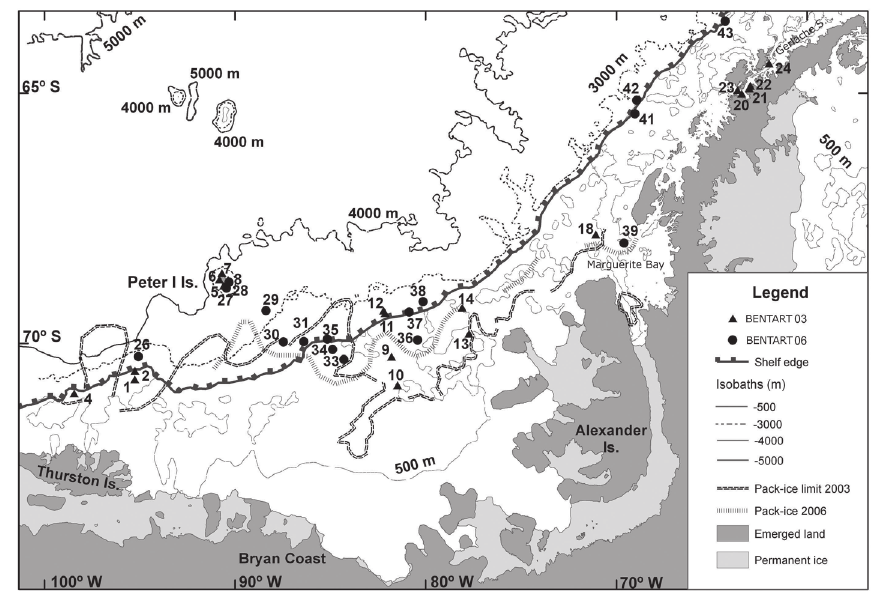
Fig. 1. – Position of the bentart-03 and bentart-06 sampling stations in the bellingshausen sea and off the western antarctic